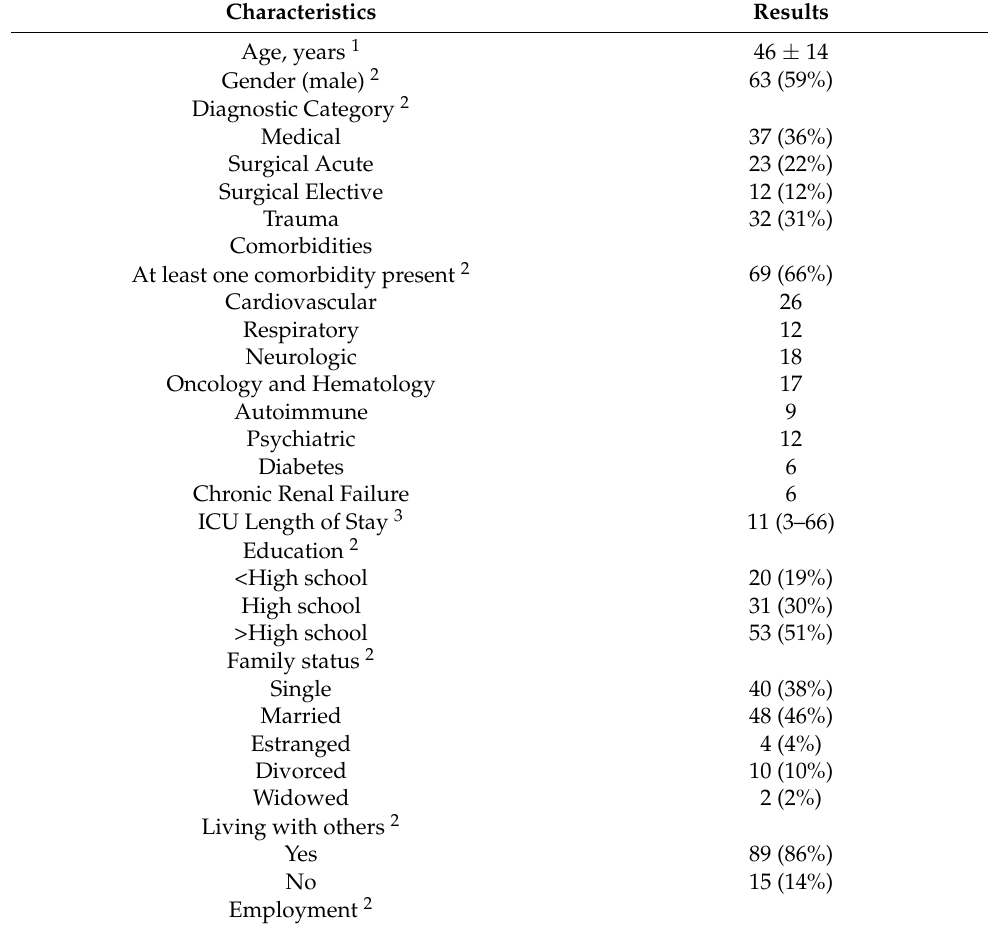
Table 1. The study population’s clinical and social characteristics and self-rated health status.